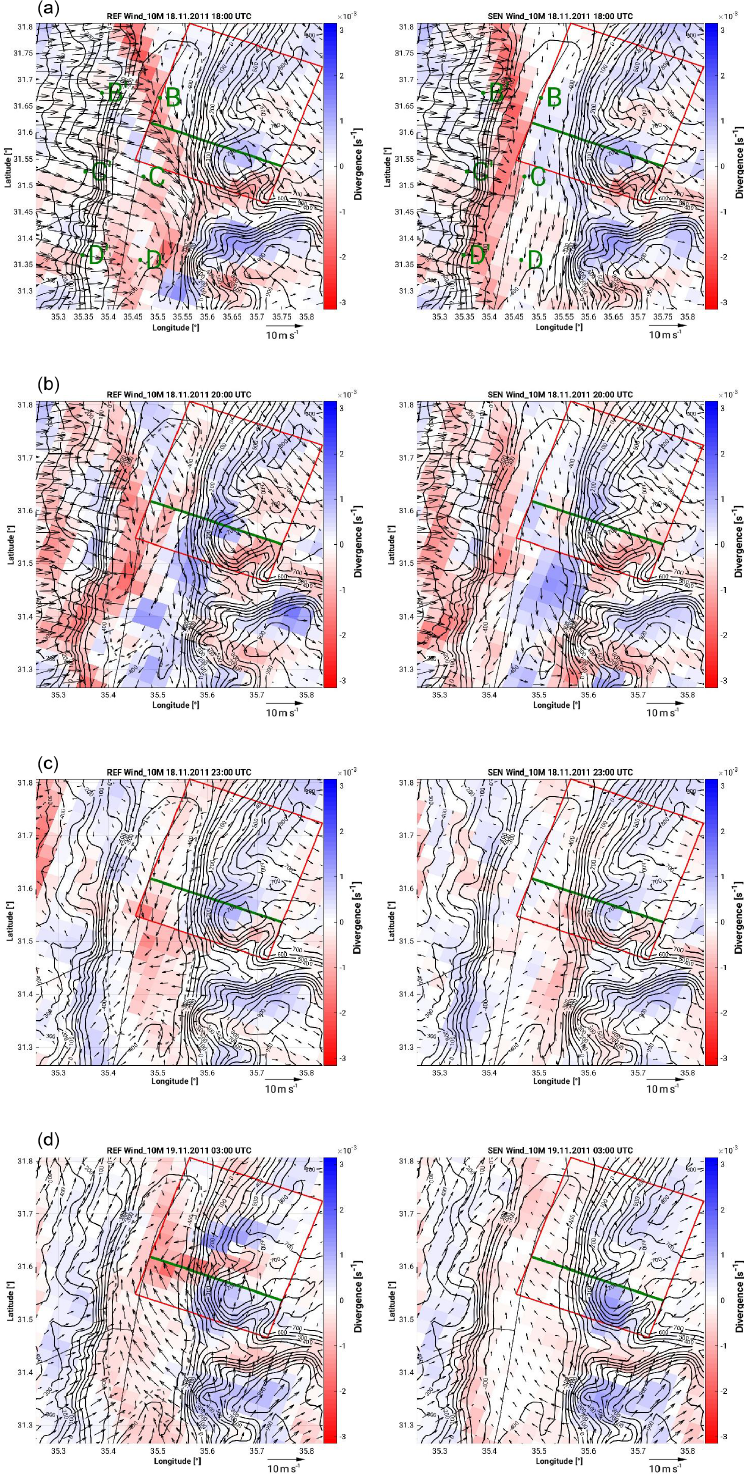
Figure 10. Spatial distribution of 10m horizontal wind (wind vectors; ms − 1 ) and corresponding divergence/convergence field (colour scale; s − 1 ) at 18:00, 20:00 and 23:00UTC on 19 November and 03:00UTC on 20 November 2011 from the REF 19 . 11 (left) and SEN 19 . 11 (right) simulations. The topography is indicated by the full black isolines. The transects (B-C-D and B (cid:48) -C (cid:48) -D (cid:48) ) corresponding to the locations in which temperature comparisons are made are indicated in (a) . The green line indicates the position of the vertical cross section in Fig.